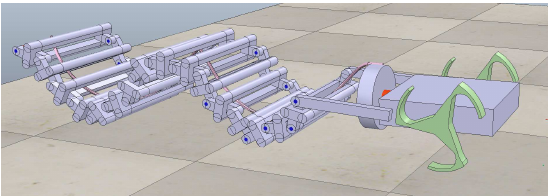
Figure 2. Introduction of whegs to facilitate the movement on uneven terrains and the climbing capabilities of small obstacles.